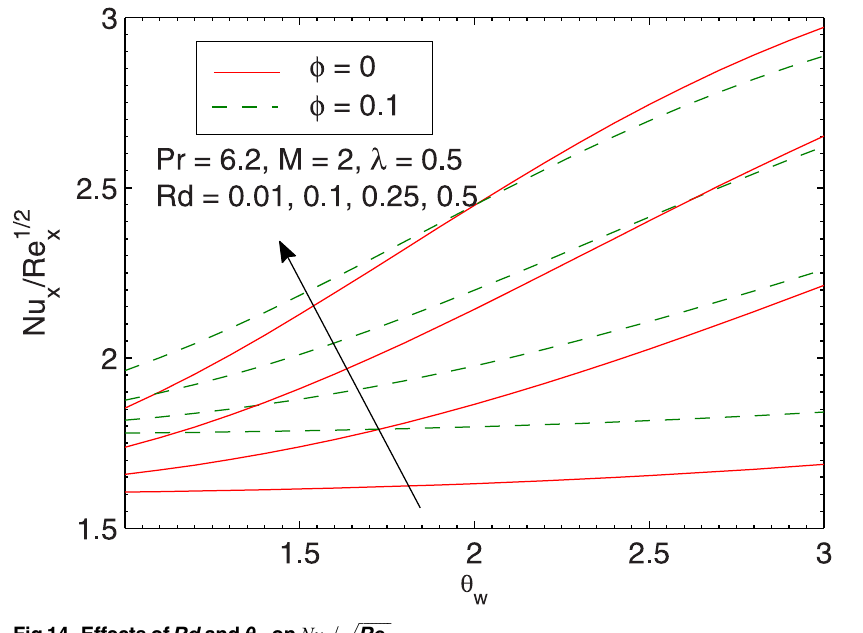
Fig 14. Effects of Rd and θ w on Nu x =